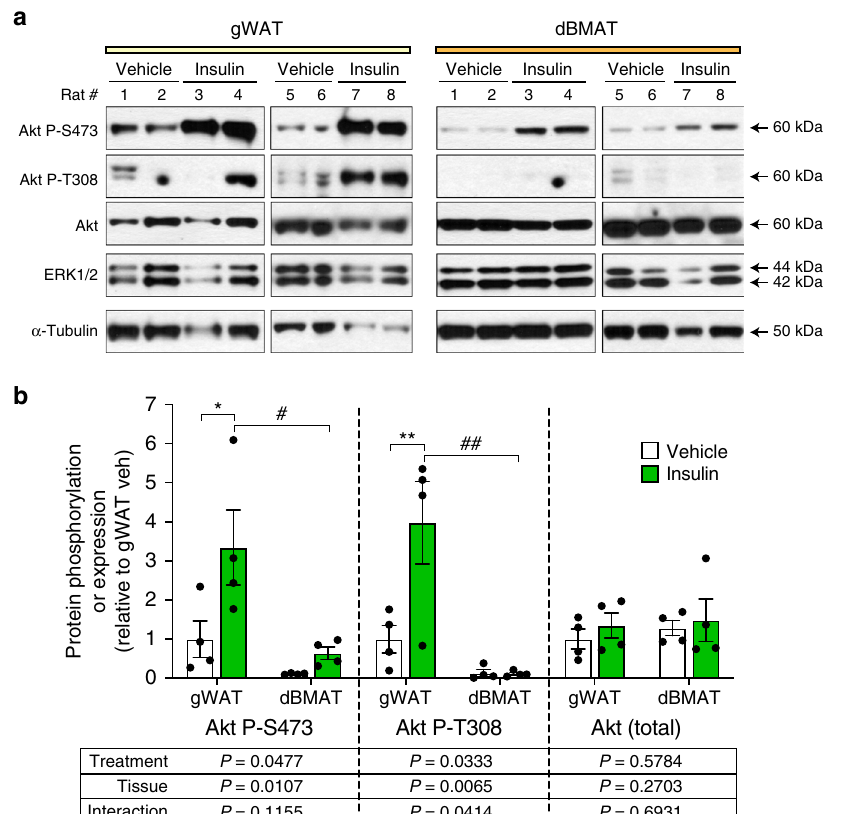
Fig. 4 BMAT resists insulin-stimulated Akt T308 phosphorylation. Male Sprague – Dawley rats at 13- to 15-weeks of age were fasted overnight prior to intra-peritoneal injection of saline ( n = 4) or 0.75 U/kg insulin ( n = 4). Tissues were isolated 15 min post-injection and total protein isolated as described in the “ Methods ” . a Expression of the indicated proteins was determined by immunoblotting, with ERK1/2 and α -Tubulin used as loading controls. b Quanti fi cation of protein expression from ( a ). Expression of Akt P-S473 and Akt P-T308 was normalised to total Akt. Expression of total Akt was normalised to the average of ERK1/2 and α -Tubulin. Data are presented relative to gWAT of vehicle-treated rats as mean ± SEM. For each protein readout the in fl uence of treatment or tissue, and interactions between these, was determined by two-way ANOVA, with p values shown beneath the graph. Signi fi cant effects of treatment (within each tissue) or tissue (within each treatment) were further assessed by multiple comparisons and are indicated as follows: insulin vs vehicle, * P < 0.05), ** P < 0.01; gWAT vs. dBMAT, # P < 0.05) or ## P < 0.01. Source data and full scans of immunoblots are provided as a Source Data fi